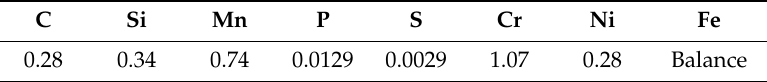
Table 1. Chemical composition of EA4T axle steel